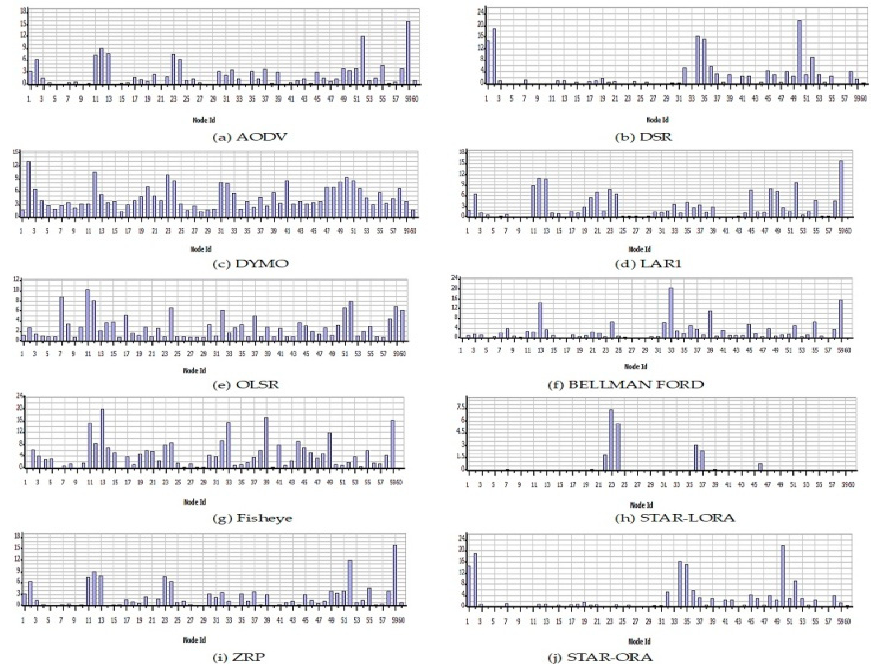
Figure 10. Transmit mode power consumption (mWh) for various routing protocols.